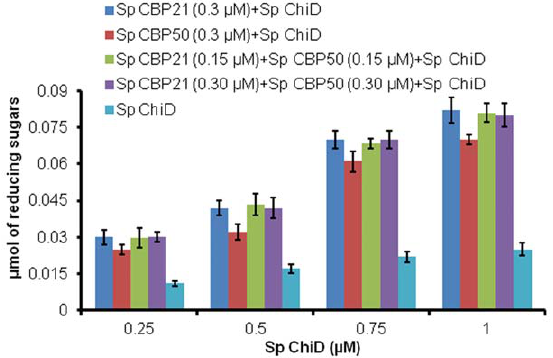
Figure 6. b -chitin hydrolysis enhancing effects of Sp CBP21 and Sp CBP50 with Sp ChiD. Reaction mixture (1 mL) containing 0.25 mg/ mL of b -chitin, 0.25 m M/0.50 m M/0.75 m M/1.0 m M Sp ChiD incubated individually with 0.3 m M of Sp CBP21/ Sp CBP50 or combining both Sp CBP21 and Sp CBP50 (0.15 m M + 0.15 m M/0.30 m M + 0.30 m M), in 50 mM sodium phosphate buffer pH 7.0. After incubation at 37 u C for 24 h at 1000 rpm, 100 m L of reaction mixture was transferred. To this 100 m L of 0.02N NaOH was added to stop the reaction and stored at 2 20 u C until products quantification by standard reducing end assay. Vertical bars represent standard deviation of triplicate